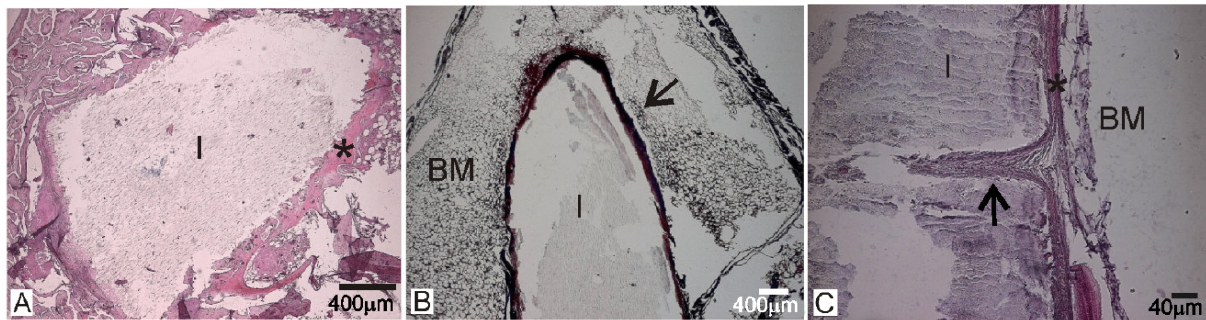
Figure 5. The histological cross-sections of the 15-month implant in bone. ( A , C ) stained with haematoxylin-eosin; ( B ) stained with Masson Trichrome. (I: implant, BM: Bone